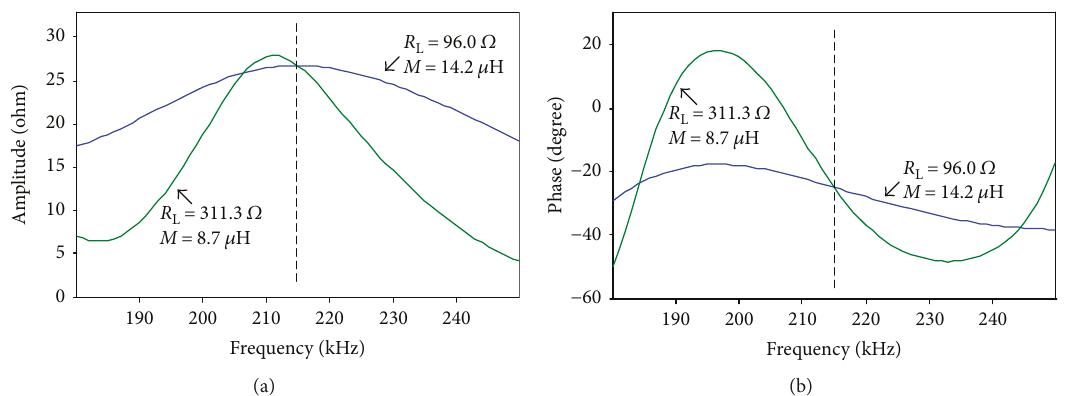
M : (a) amplitude versus L and mutual inductance